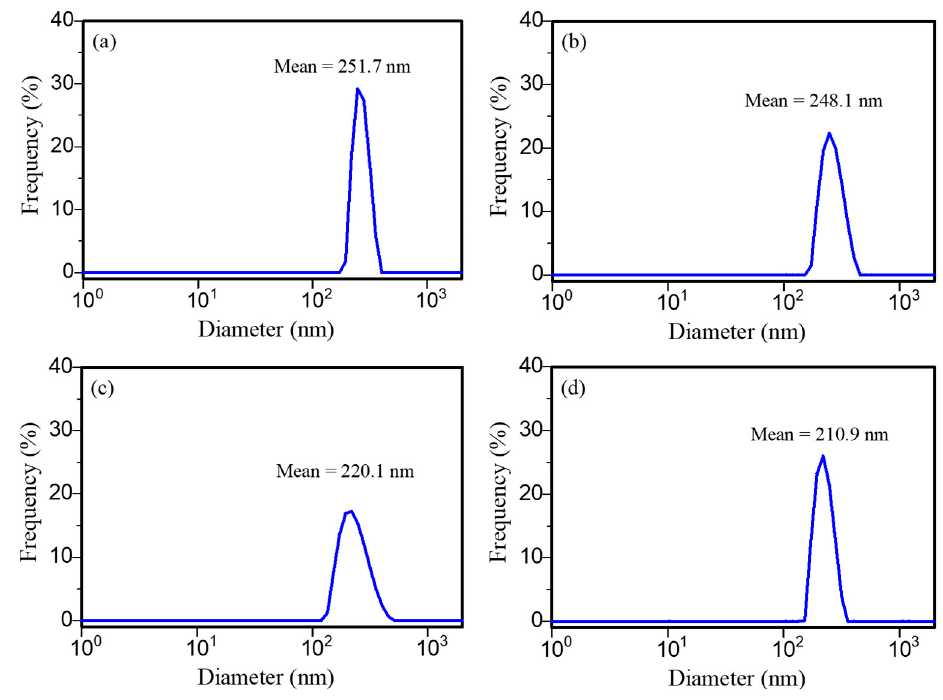
Figure 4. PSA histogram ( a ) TiO 2 P25, ( b ) TiO 2 /SiO 2 1:1 ratio, ( c ) TiO 2 /SiO 2 3:1 ratio, and ( d ) TiO 2 /SiO 2 7:1 ratio. TiO 2 /SiO 2 7:1 ratio. Table 6. Data measurement results using a PSA (particle size analyzer). Table 6. Data measurement results using a PSA (particle size